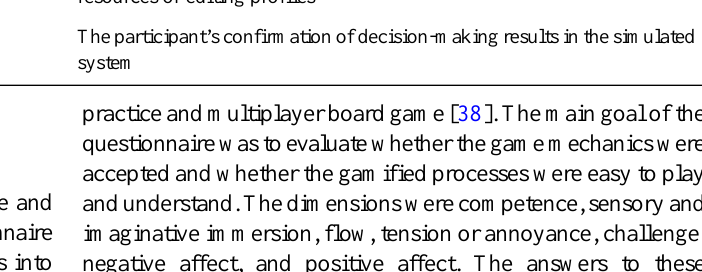
Scoring-based game mechanicsIndicator